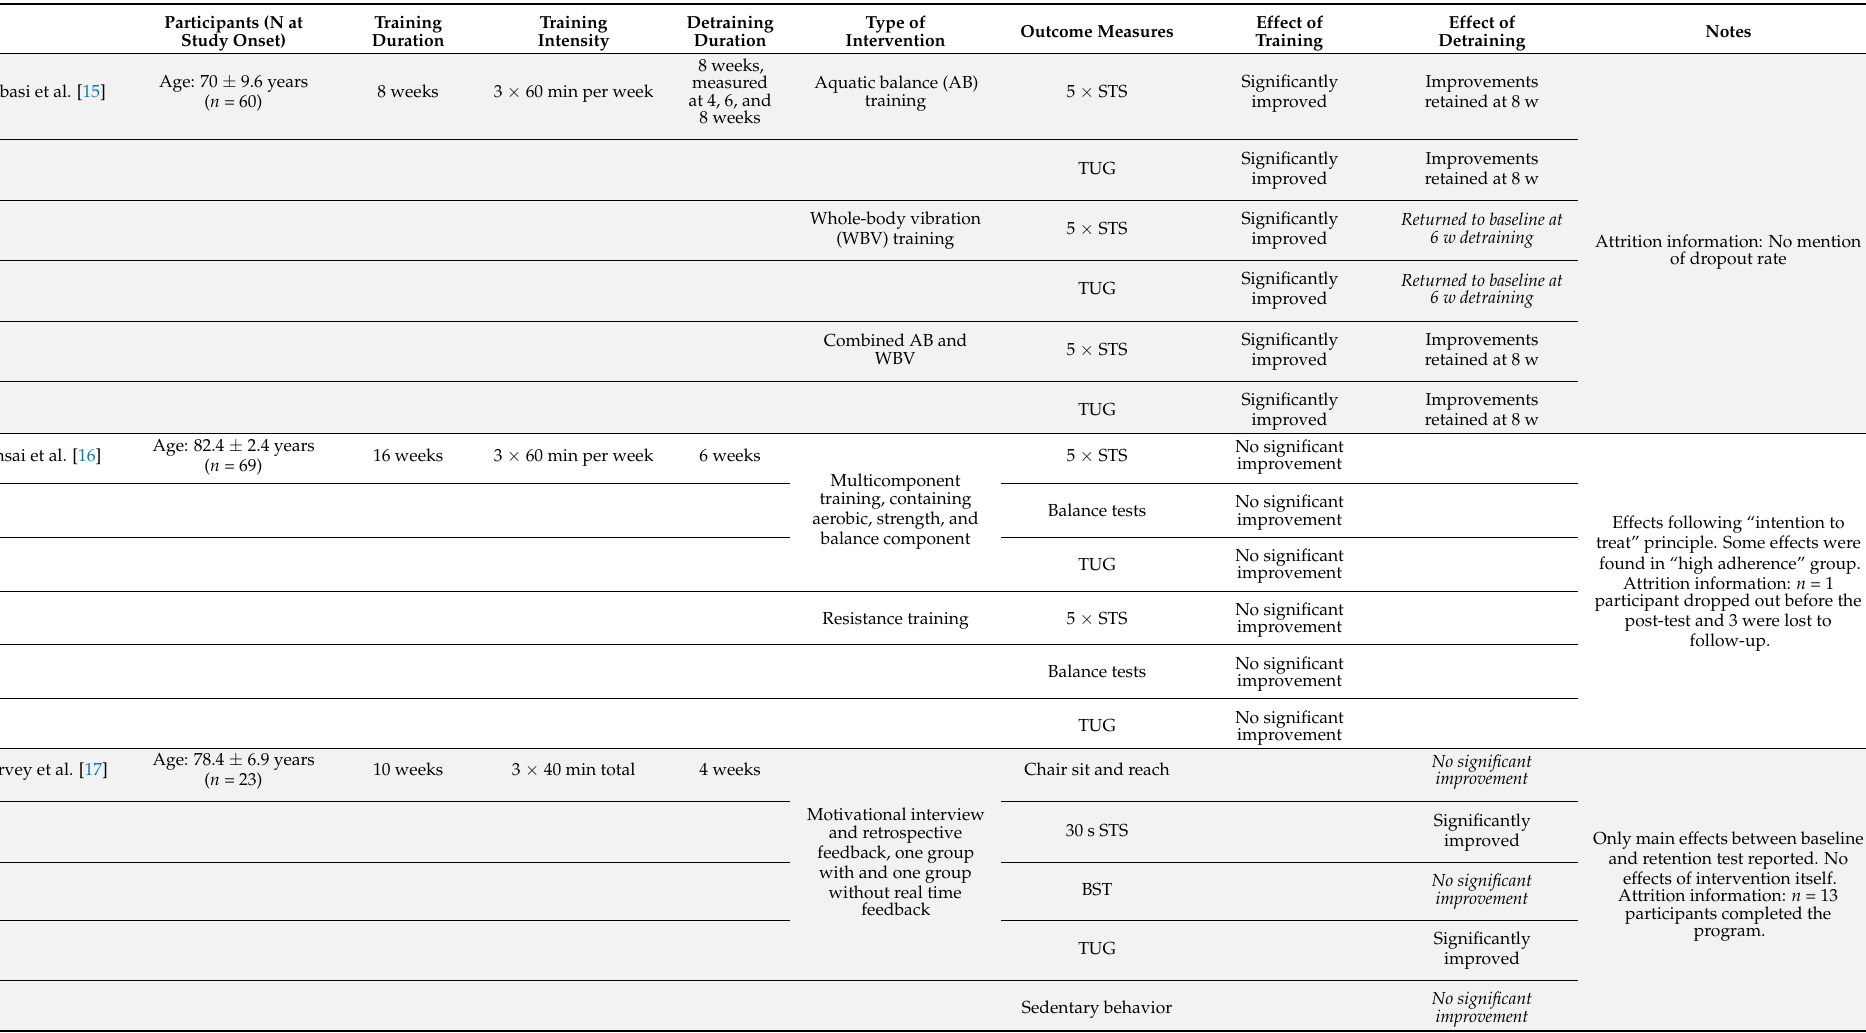
Table 1. Data extraction table collating the characteristics from the ( n = 9) included